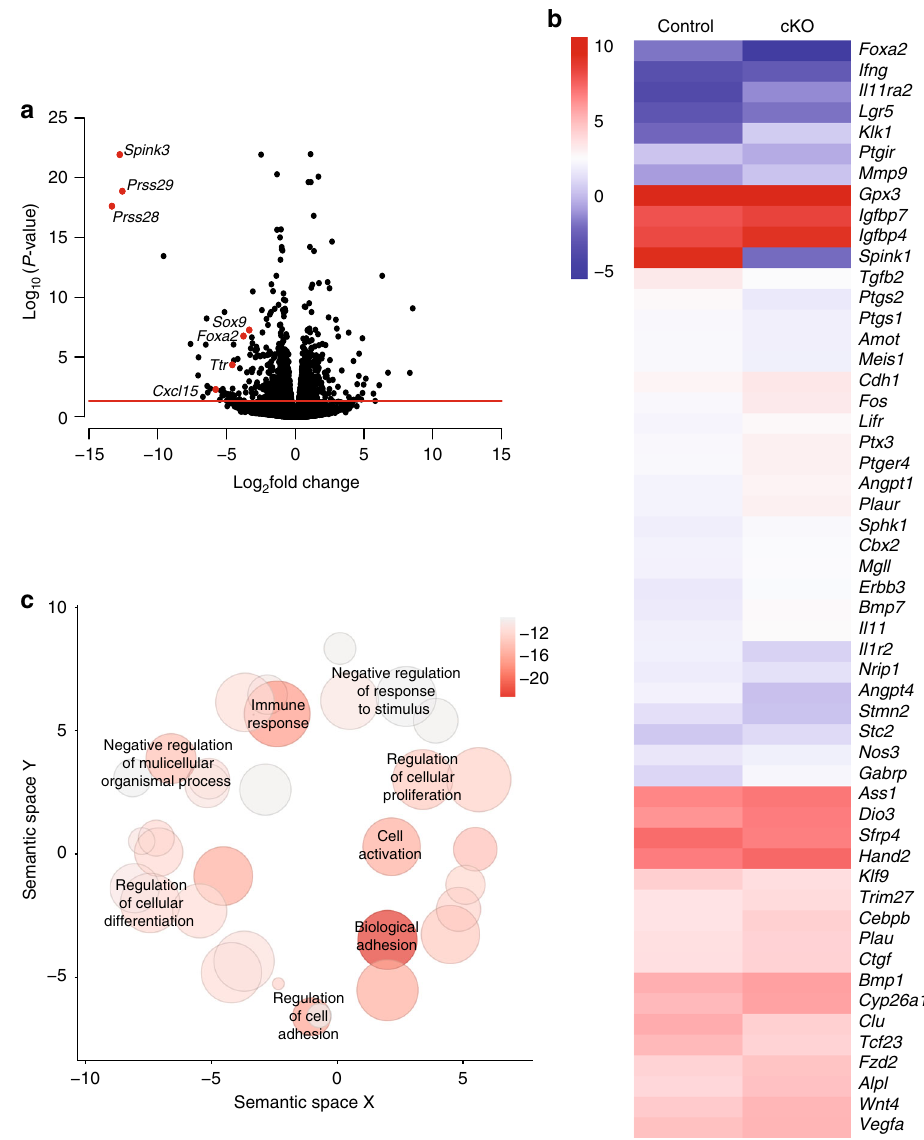
Fig. 6 The uterine transcriptome is dysregulated in the implantation sites of GD 6 mice that lack endometrial glands. RNA-sequencing analysis was conducted using implantation sites from LIF-replaced glandless and control mice on GD 6 ( n = 4 per genotype). a Volcano plot of all genes detected in transcriptome analysis. All data points above the red horizontal line are signi fi cant. Known gland-speci fi c genes have red points and are labeled with gene names. b Heatmap for 53 genes (log2 FPKM values) known to be involved in decidualization that were different in GD 6 implantation sites in LIF-replaced glandless Pgr Cre/ + Foxa2 f/f mice. c Visualization of biological process GO terms associated with genes differentially expressed in LIF-replaced glandless Pgr Cre/ + Foxa2 f/f and control mice on GD 6. Color indicates the FDR P value and size indicates the frequency of the GO term in the underlying annotation database. Darker circles with a larger size represent highly signi fi cant terms that are more